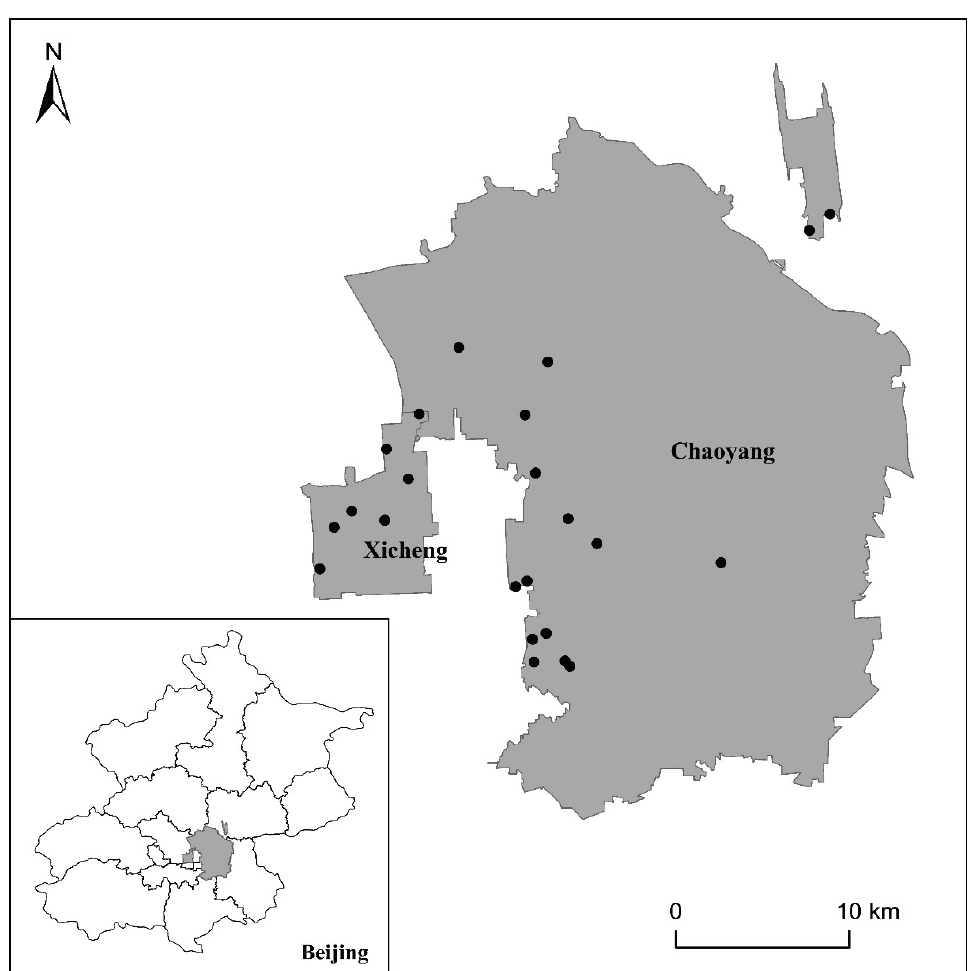
Figure 1. The black points show the sampling schools located in Xicheng and Chaoyang Districts,